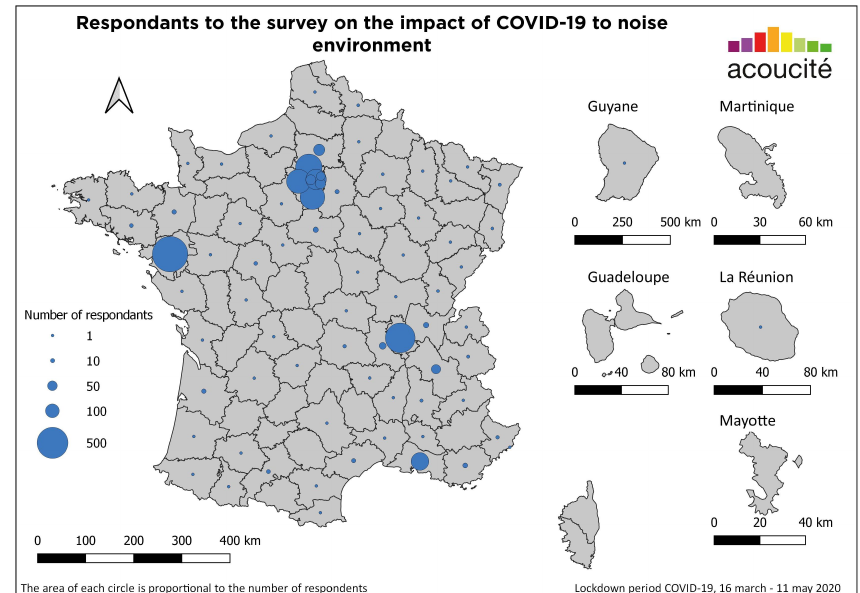
Figure 1: Geographical distribution of respondents. View of France